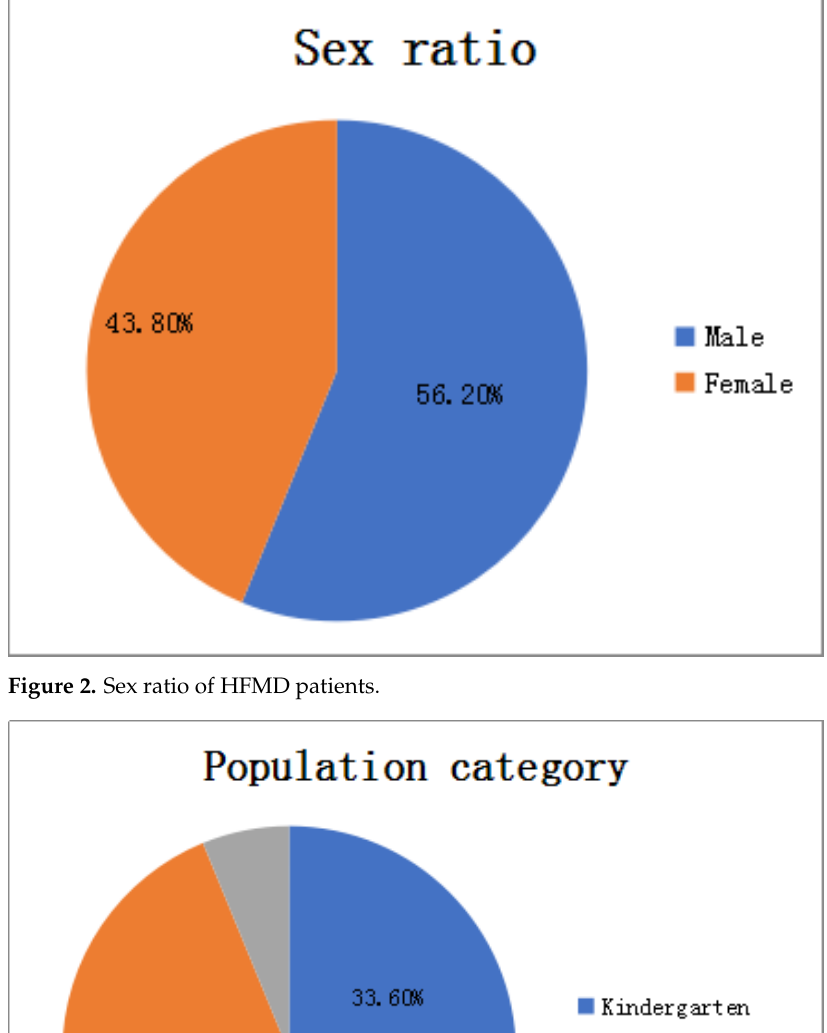
Figure 3. HFMD’s proportion of each population